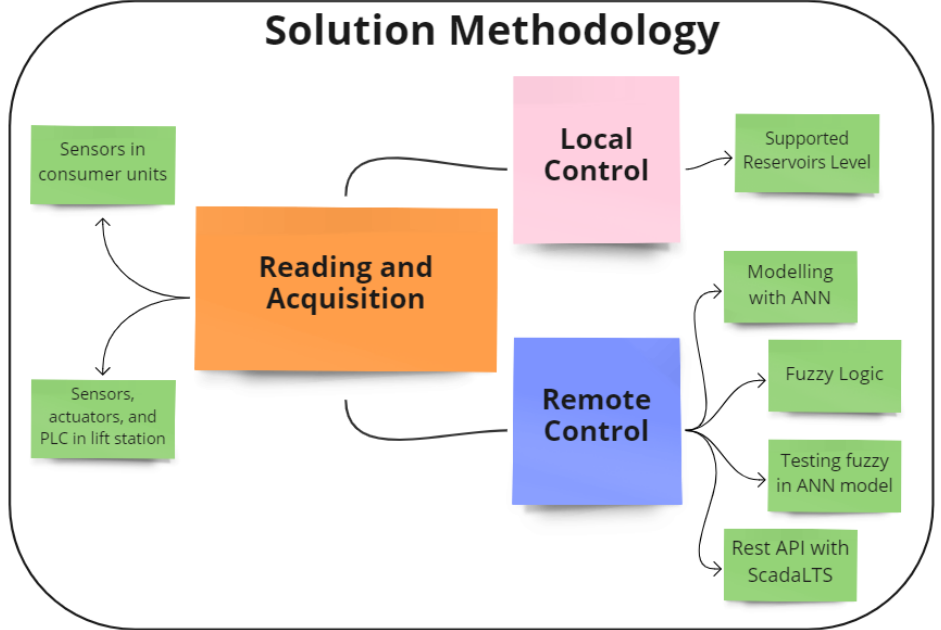
Figure 14. Schematic of the proposed methodology. Source: author,